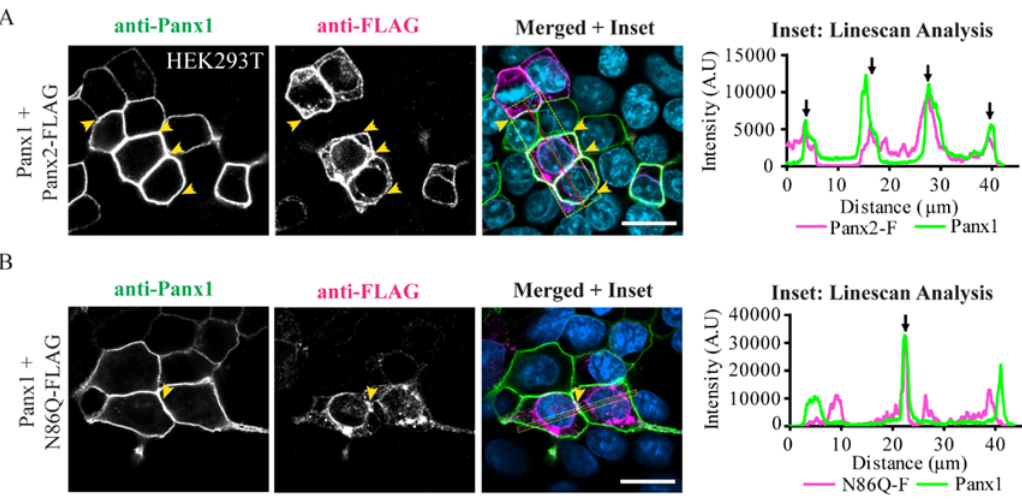
Figure 7. N-glycosylation may enhance plasma membrane localization of Panx2 when co-expressed with Panx1. Confocal micrographs of ( A ) Panx2-FLAG or ( B ) N86Q-FLAG (magenta) ectopically co-expressed with mouse Panx1 (green) in HEK293T cells. 72 h post-transfection Panx2-FLAG partially colocalized with Panx1 at the cell membrane (see black arrows in Linescan, panel A ) with a subpopulation still in intracellular compartments. N86Q-FLAG formed intracellular aggregates and showed limited colocalization with Panx1 at the plasma membrane (see black arrows in Linescan, panel B ). Yellow arrowheads denote regions of colocalization of Panx1 and FLAG labeling also depicted with black arrows in the corresponding linescans. Insets: Linescans showing the overlapping (black arrows) between fluorescence peaks to denote colocalization. Nuclei (blue, Hoechst 33342). Scale bars = 20 µ